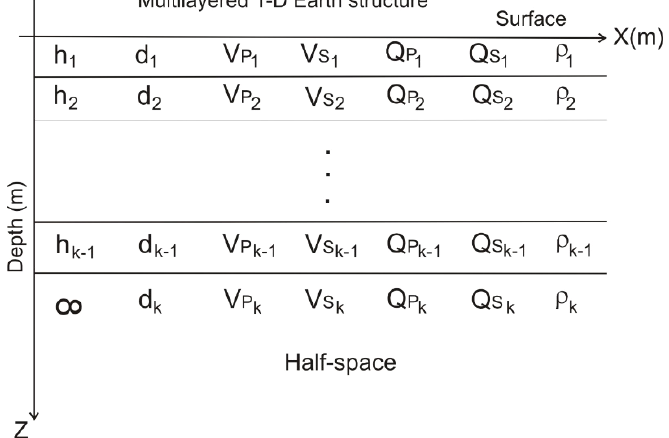
Figure 1. Stratified one-dimensional (1-D) seismic and resistivity model structure is shown. For more information see the